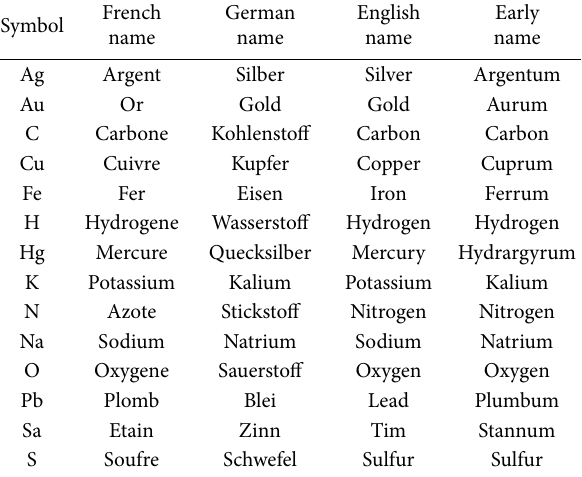
Figure 1. The 14 elements with the greatest variety of names according to Seidell